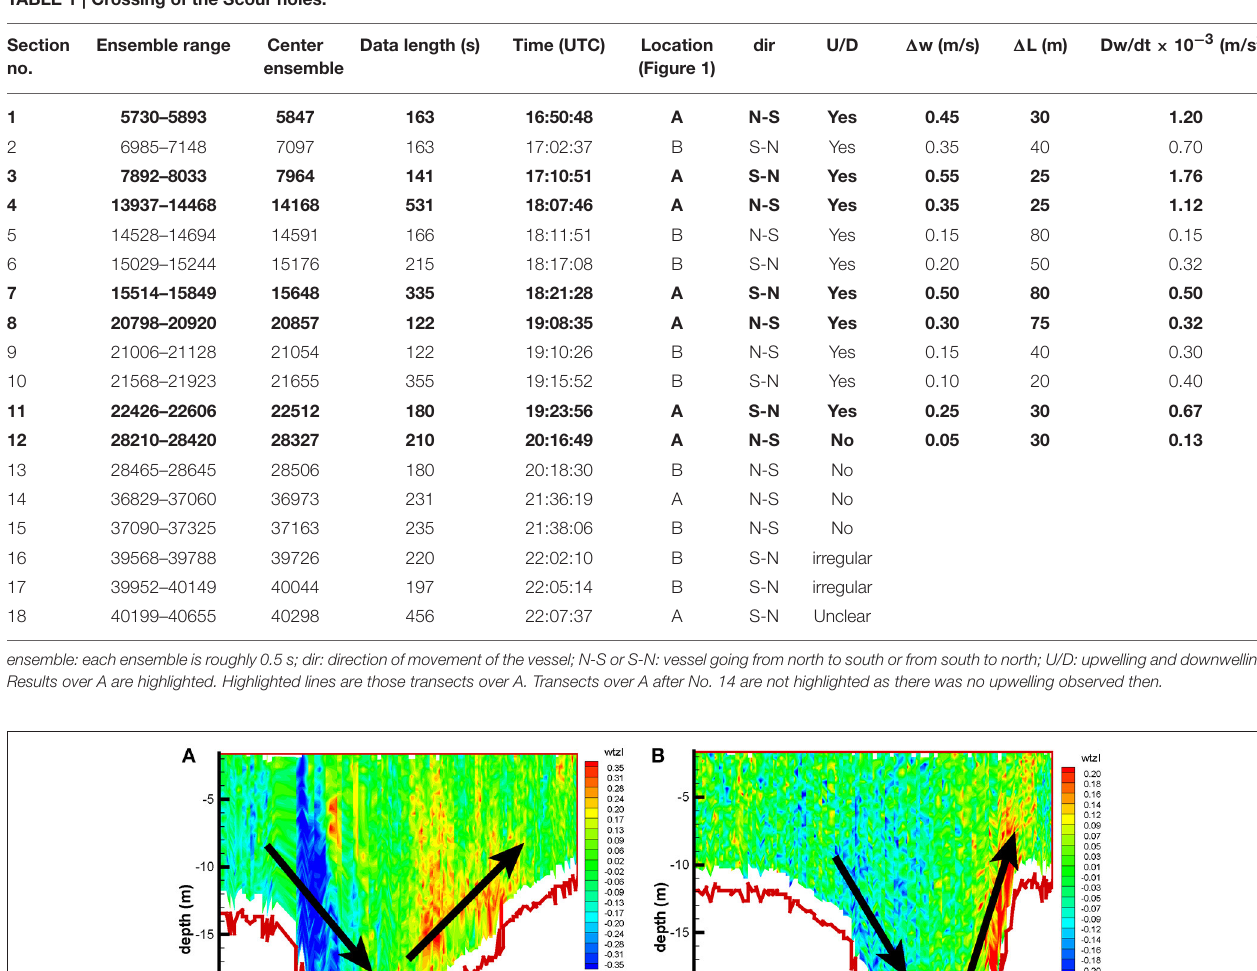
waves. The contrast was quite remarkable to the naked eyes. The maximum horizontal flow was at the constriction between A and B ( Figure 1 ), where the bottom was flat and where there was no obvious vertical motion. Turbulence and vertical flow were more intense over the northern hole ( Figure 1A ) than the